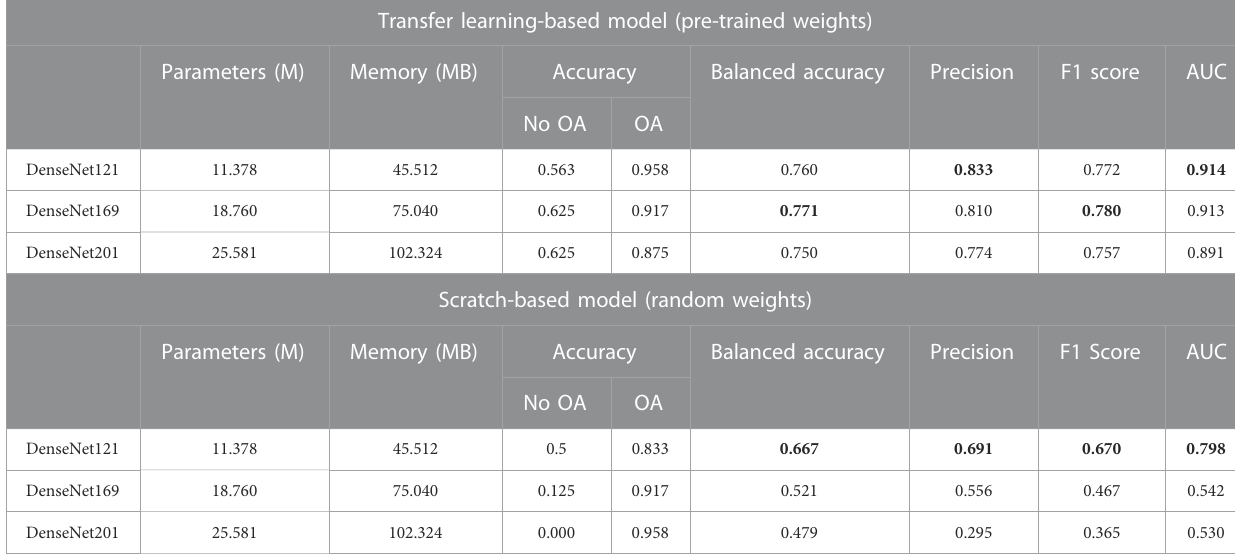
TABLE 3 Performance comparison of DenseNet